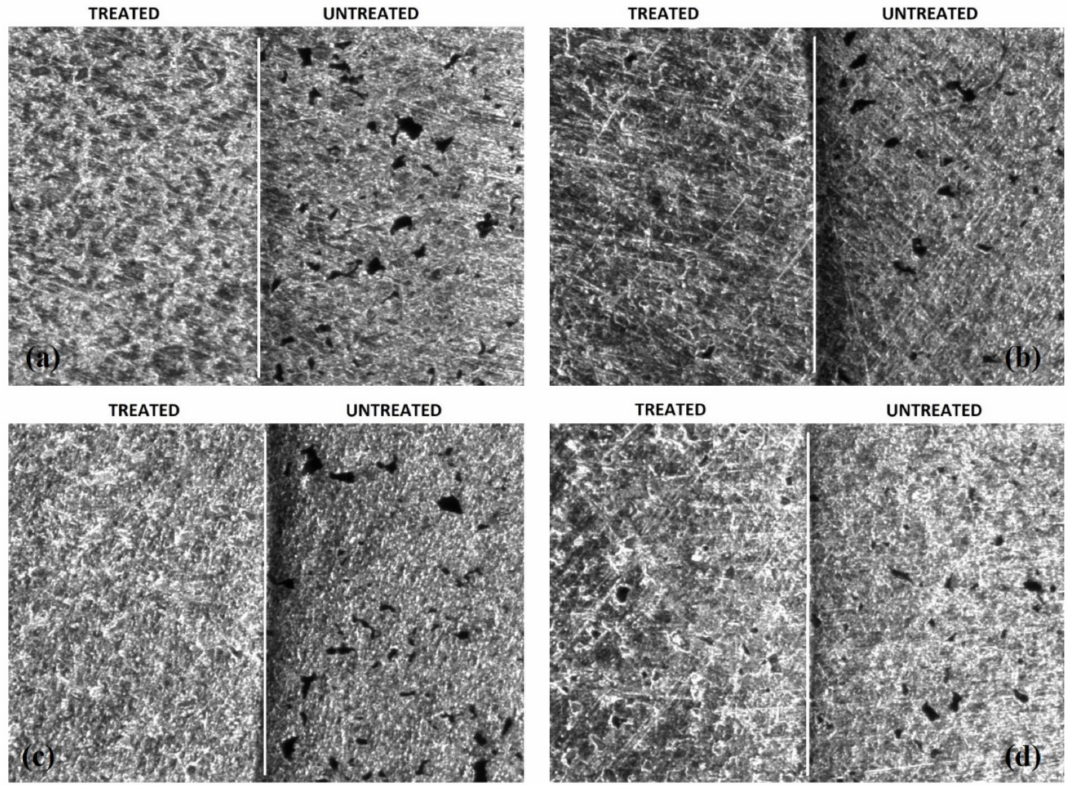
Figure 10. Optical microscope pictures (40x) of treated/untreated surfaces of ( a ) EPD TiN-06, ( b ) EPD TiN-07, ( c ) EPD TiN-08, ( d ) EPD